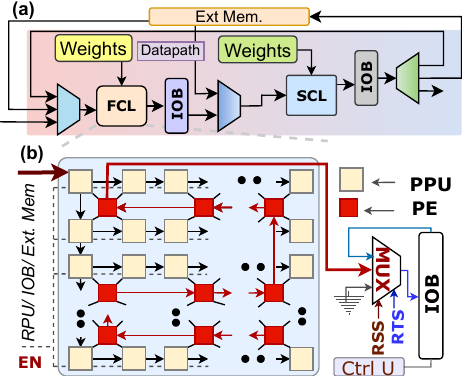
Figure 7. ( a ) Block diagram of an inference engine. There is configurable data-path between FCL and SCL ( b ) Block diagram of the